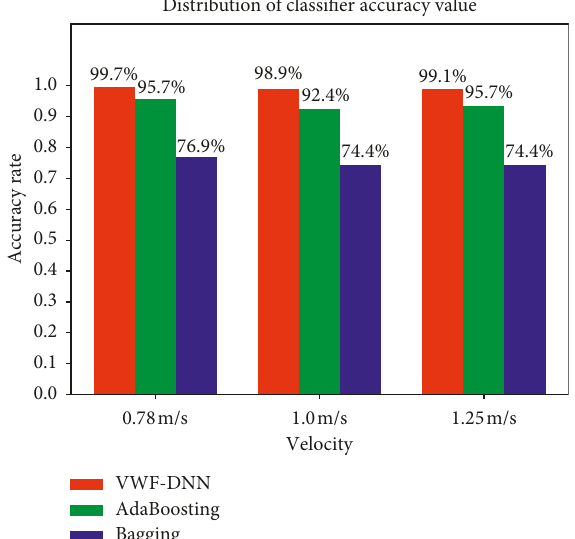
Figure 11: More tag set classifier accuracy distribution at three paces.